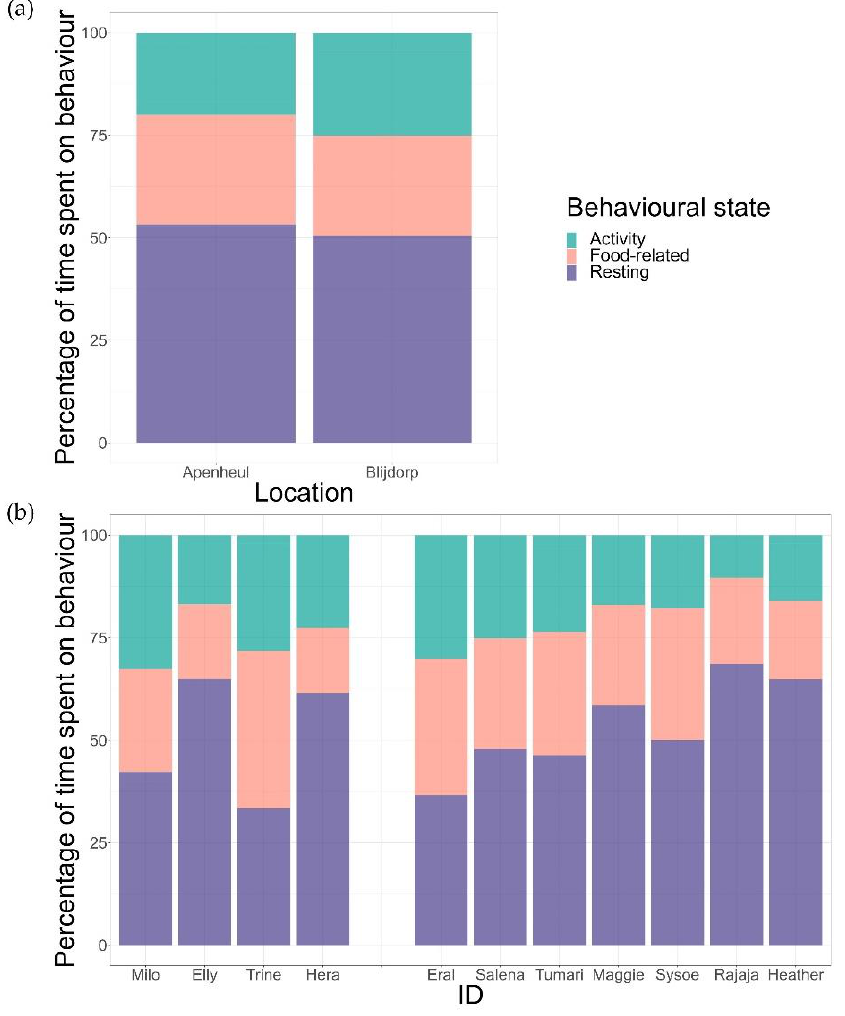
Figure 1. ( a ) Time-activity budget of AP and BZ groups; ( b ) Time-activity budgets of all individuals separated by location, with BZ on the left and AP on the right.